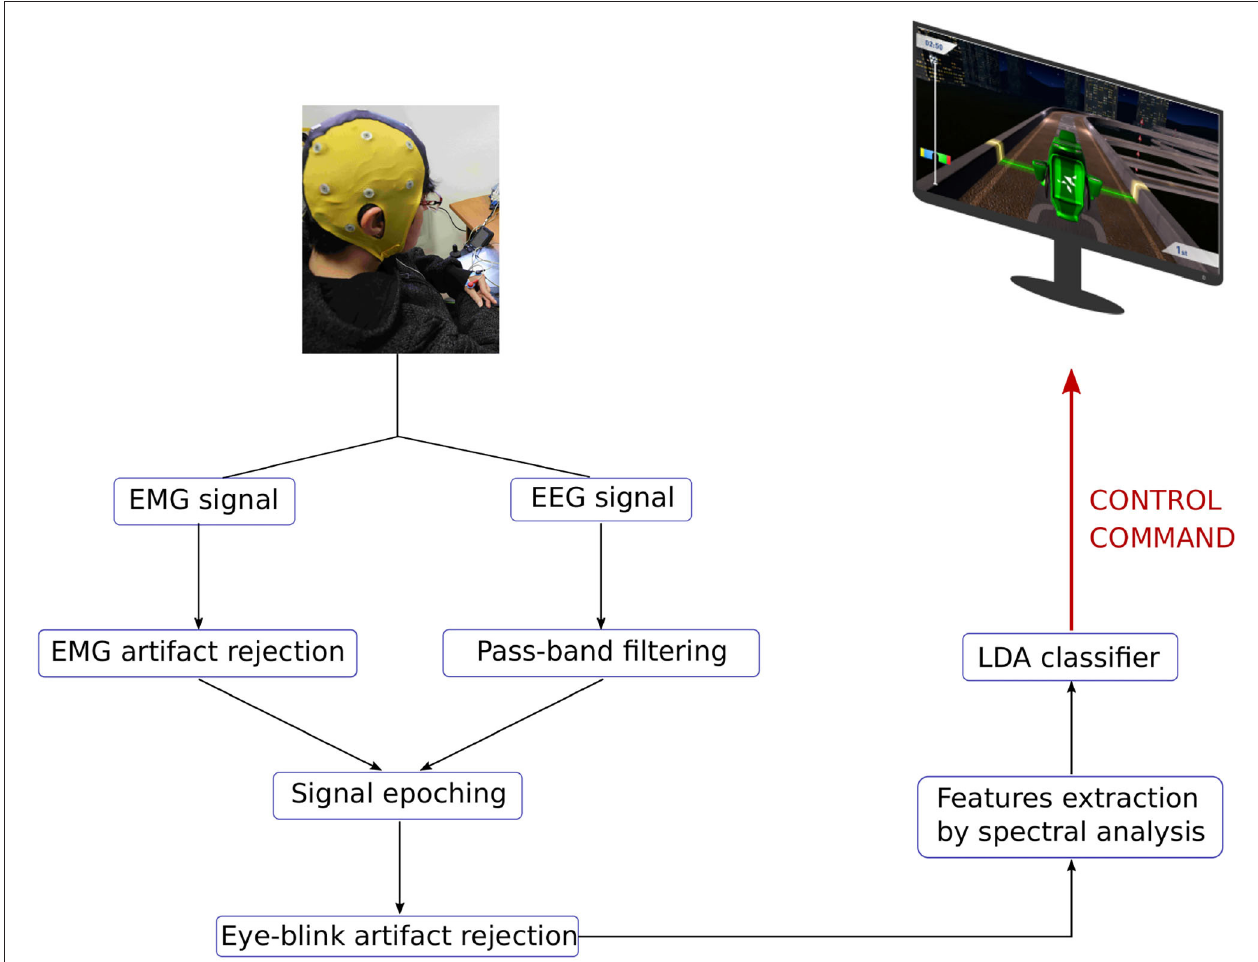
FIGURE 7 | Outline of the closed-loop BCI